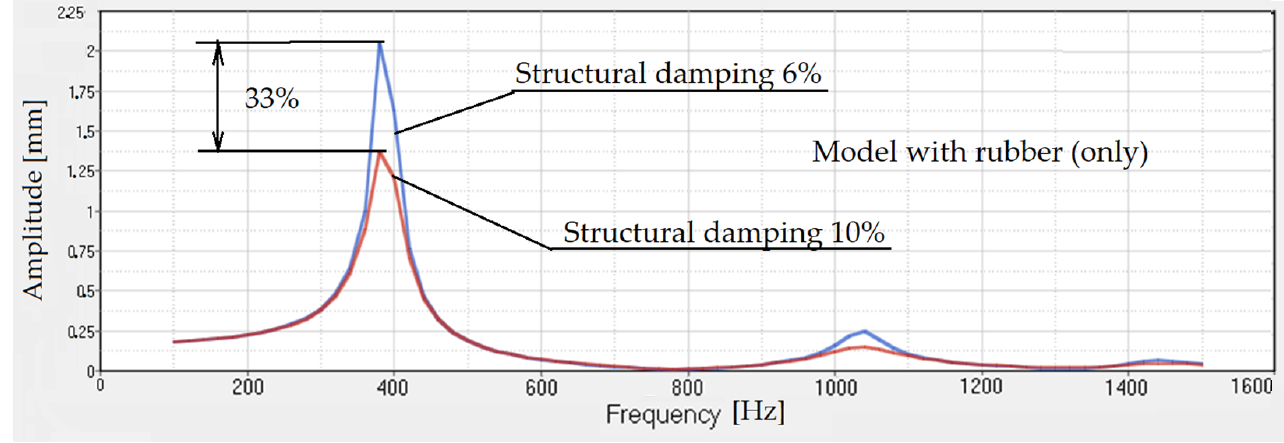
Figure 11. Transmissibility for rubber without balls. The structural damping is 6% and 10%.